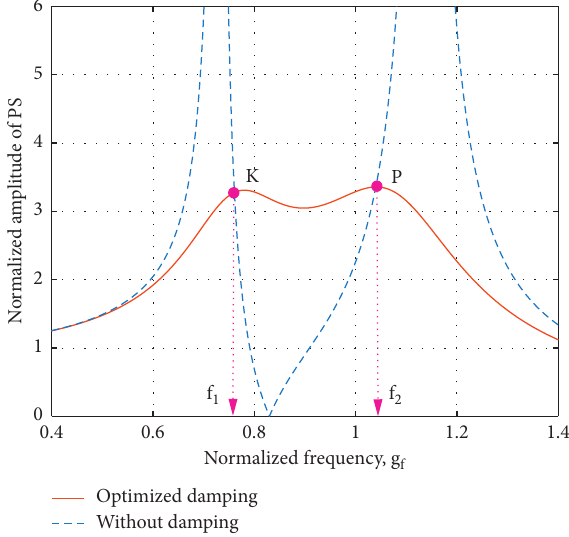
Figure 4: Amplitude-frequency response of the protected